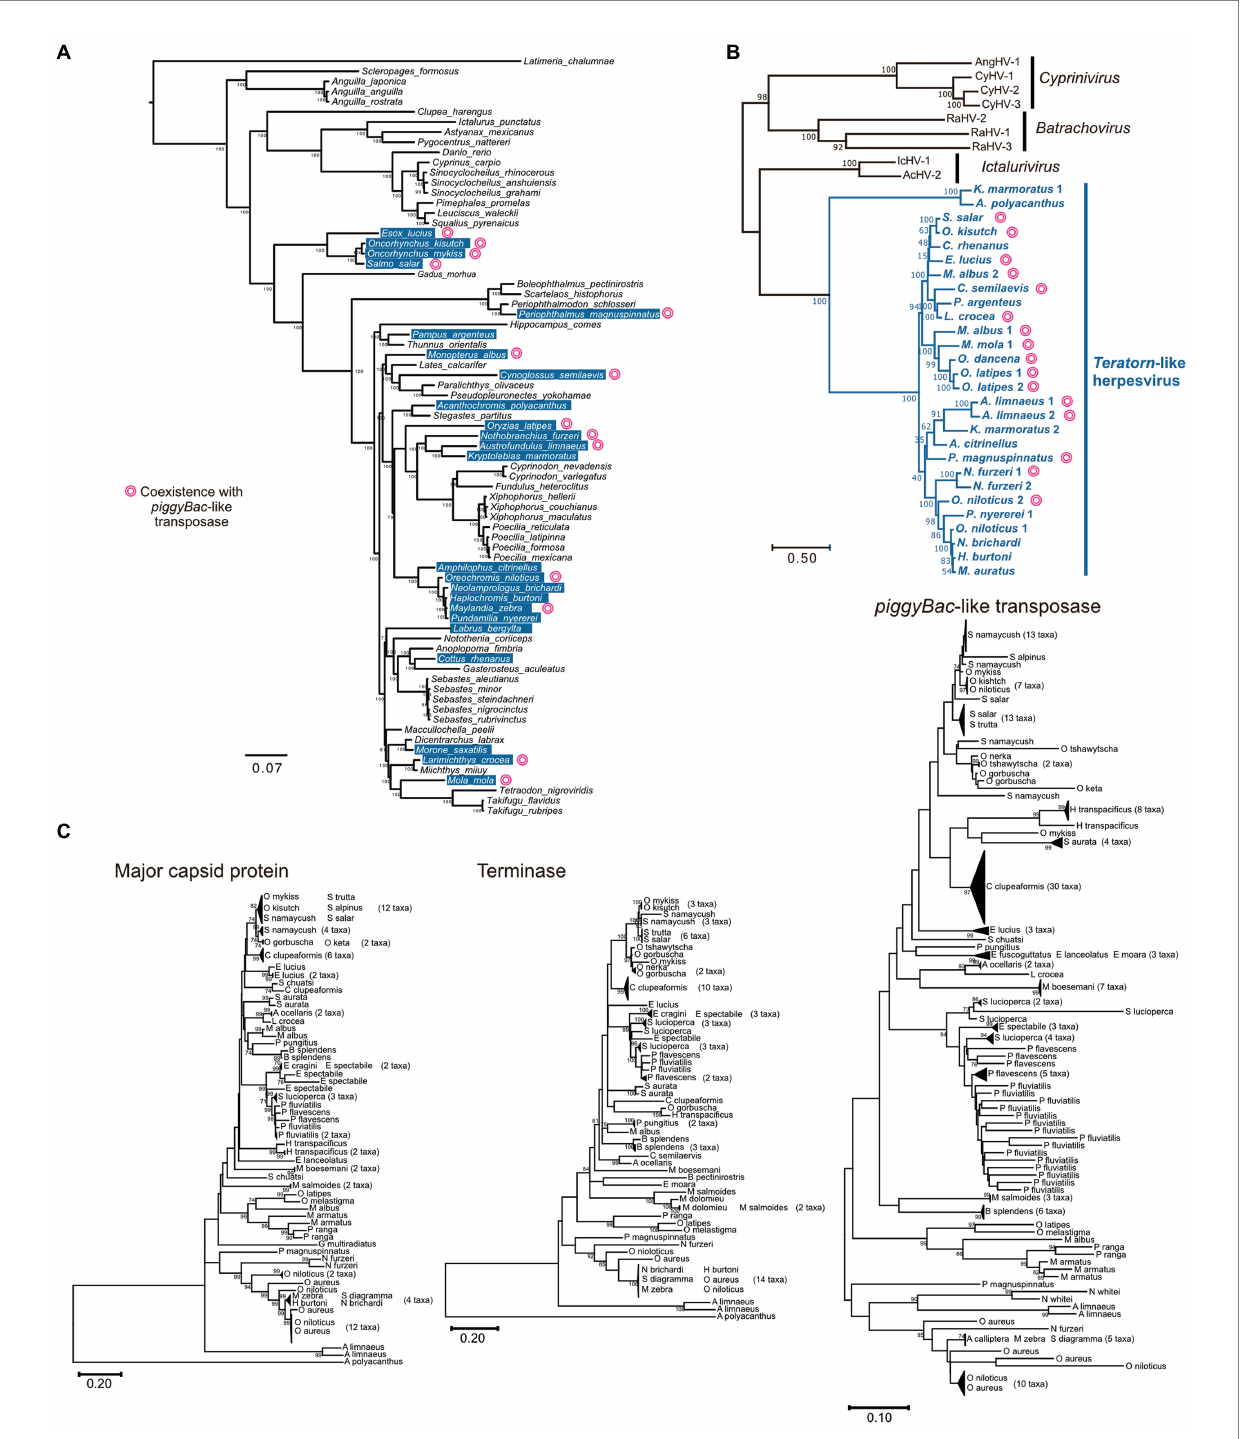
FIGURE 3 Widespread distribution of Teratorn -like herpesviruses in teleosts. (A) Distribution of Teratorn -like herpesviruses in the genomes of teleost fish species. Species that seem to contain Teratorn -like herpesvirus are highlighted in blue (greater than nine of the 13 herpesvirus core genes, tblastn E -value <10 − 3 ). The phylogenetic tree was constructed by bayesian inference, based on the concatenated nucleotide sequence of nine nuclear genes (64). Species in which Teratorn -like herpesviruses are adjacent to piggyBac -like transposase genes are marked. (B) Phylogeny of Teratorn -like herpesviruses and other alloherpesvirus species, based on the maximum-likelihood analysis. The concatenated amino acid sequences of five herpesvirus genes (major capsid protein, DNA helicase, DNA polymerase, capsid triplex protein, and DNA packaging terminase) were used. (C) Maximum-likelihood trees based on the nucleotide sequences of major capsid protein, DNA packaging terminase, and piggyBac -like transposase genes inside re-screened Teratorn -like herpesvirus sequences. General time reversible model was used as a substitution model, considering evolutionary rate differences among sites by discrete Gamma distribution with five categories. Total of 2,878 positions (major capsid protein), 756 positions (DNA packaging terminase), and 558 positions ( piggyBac -like transposase) were used in the final dataset. Nodes of phylogenetic trees were collapsed if the sequence similarity was greater than 98% for major capsid protein and terminase, and greater than 96% for piggyBac -like transposase. Non-collapsed trees are shown in Supplementary Figure 1. The scale bars represent the number of substitutions per